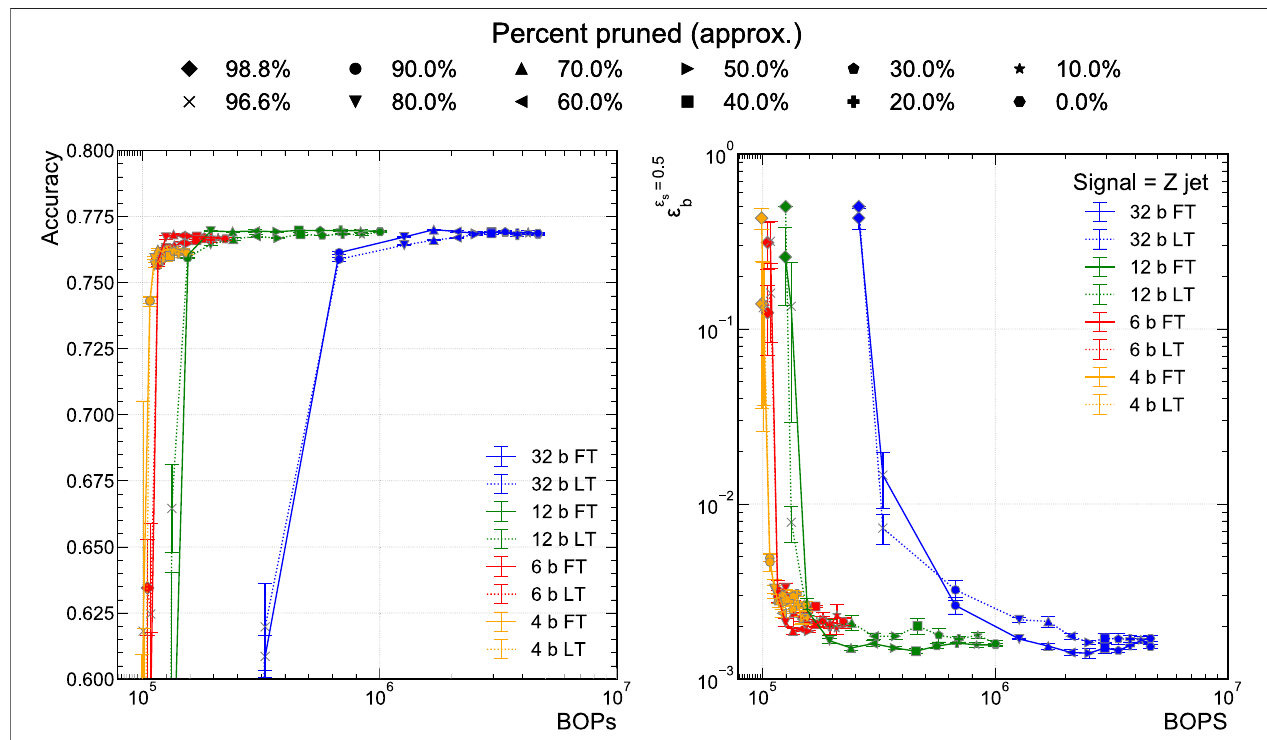
FIGURE 4 | Model accuracy (A) and background ef fi ciency (B) at 50% signal ef fi ciency versus BOPs for different sparsities achieved via QAP, for both FT and LT pruning